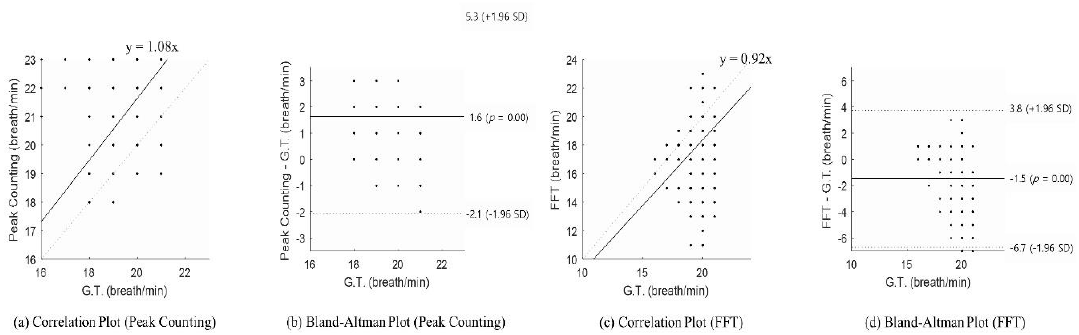
Figure 6. Statistical evaluation to compare other methods: ( a ) correlation plot of peak counting, ( b ) Bland – Altman plot of peak counting, ( c ) correlation plot of the FFT, and ( d ) Bland – Altman plot of the FFT. G.T.: Ground Truth.